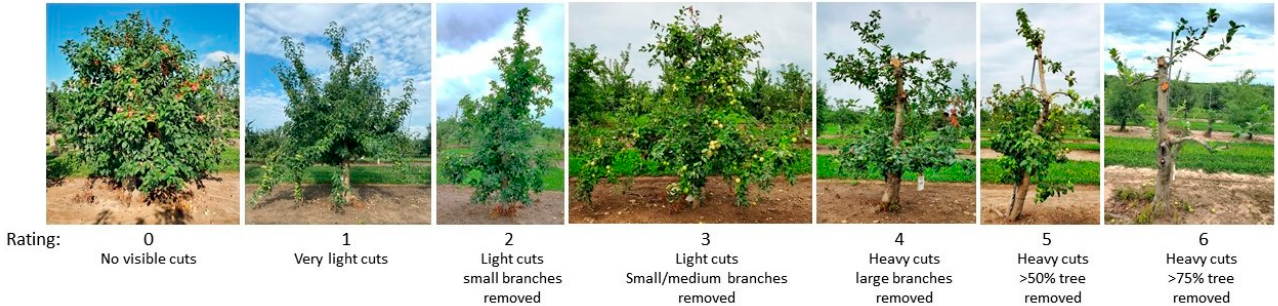
Figure 2. A visual representation of cut severity ratings with score and general description below each image.